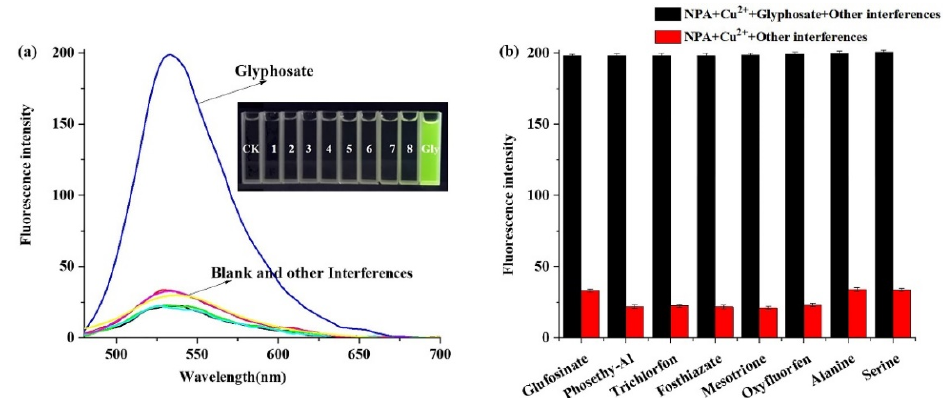
Figure 8. ( a ) Fluorescence spectral changes in NPA-Cu 2+ toward various pesticides (Gly: glyphosate); ( b ) fluorescence response of NPA-Cu 2+ upon the addition of various